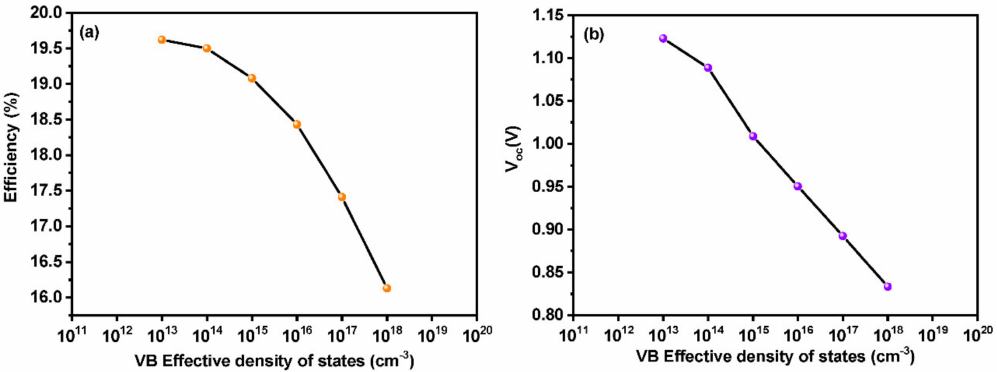
Figure 5. Effect of density of States on ( a ) efficiency and ( b ) V oc of the